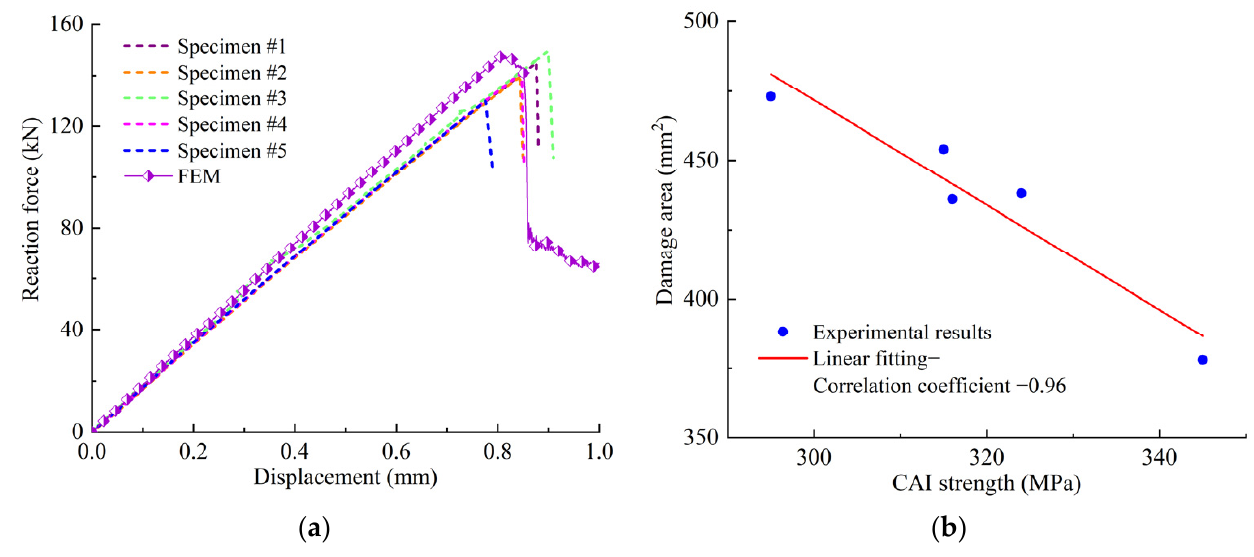
Figure 5. Reaction forces and CAI strengths of specimens. ( a ) Reaction forces versus displacement curves. ( b ) Relationship between damage area and CAI strength. Table 2. Damage areas and CAI specimens of the specimens. Maximum Contact Impact Damage Specimen Area (mm 2 )